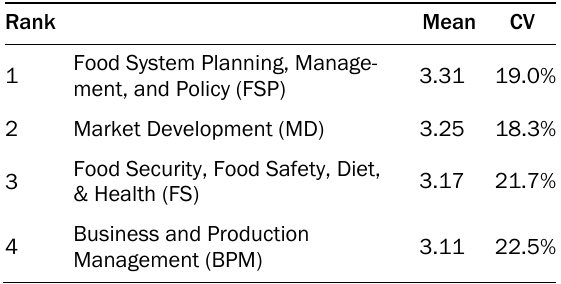
Table 4. Priority Ranking of Survey Categories by Mean Score (Most important to less important)